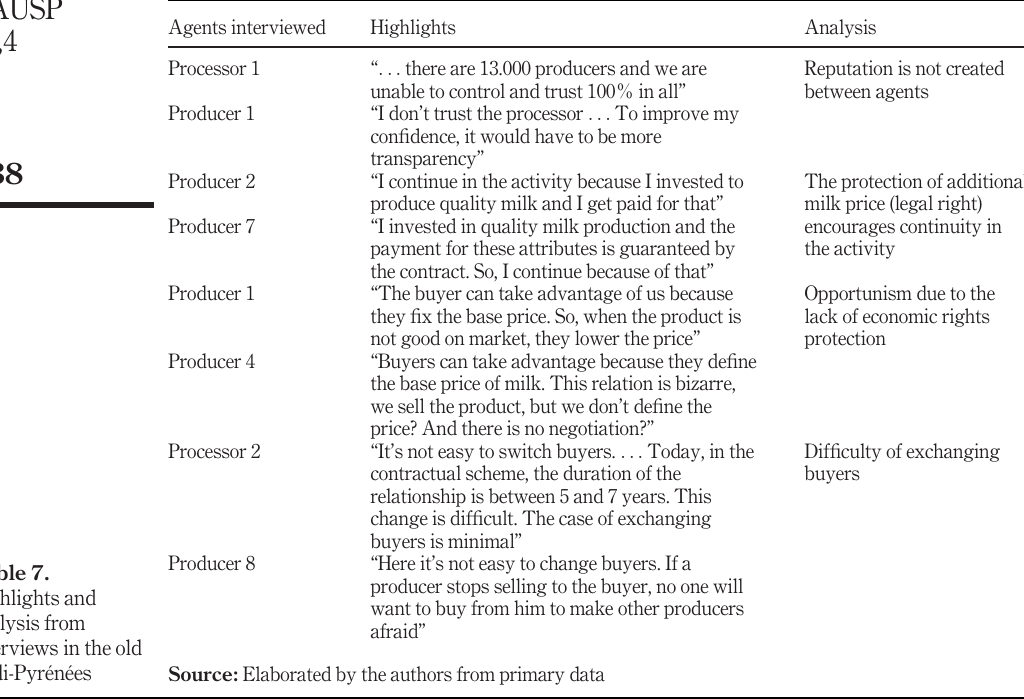
analysis from interviews in the